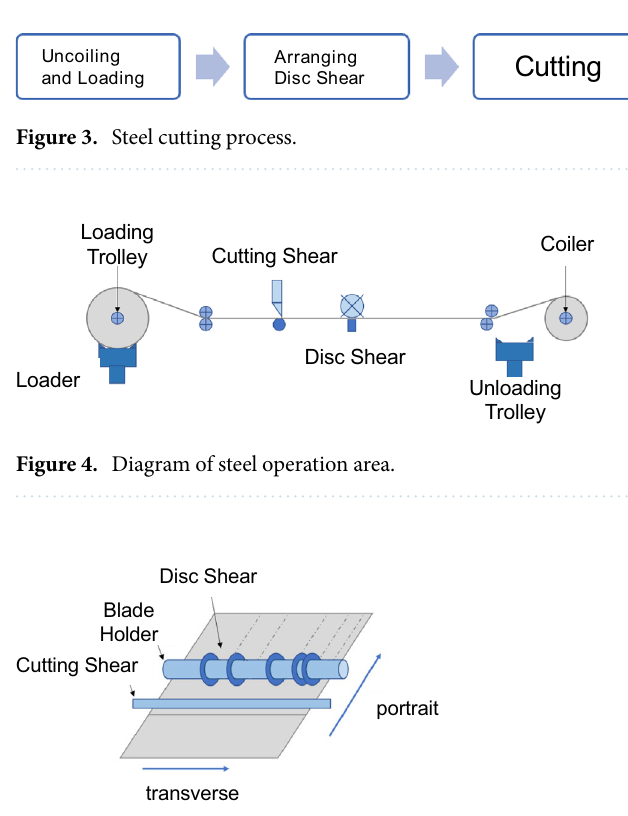
Figure 5. Schematic diagram of disc shear.